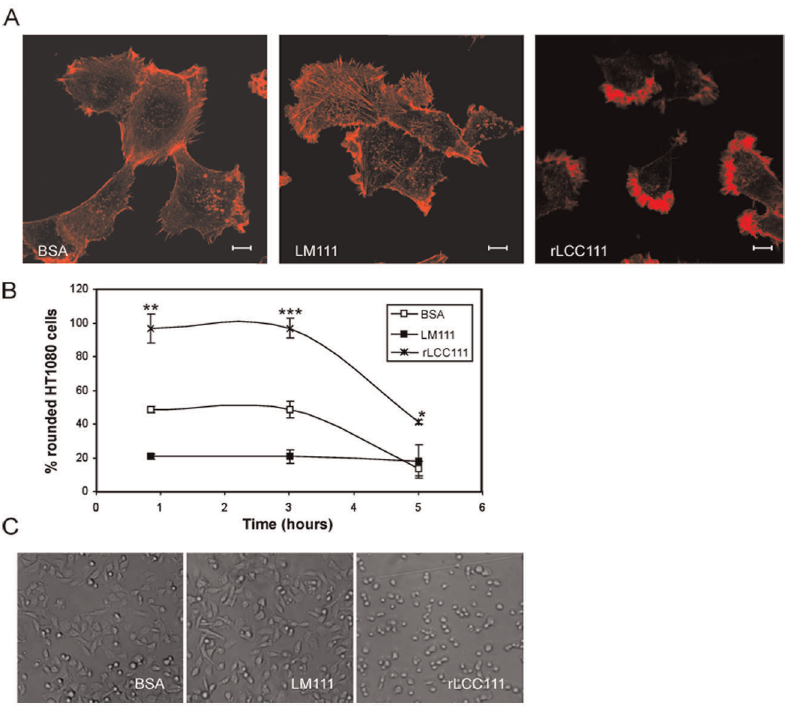
Figure 6. Morphology of HT1080 cells cultured on tissue culture plates coated with BSA, intact LM111 or rLCC111 (10 mg/ml). Cells were allowed to attach for 6 hours, followed by fixation and staining with Alexa Fluor 594 phalloidin (A). Scale bar is 10 m m. Spread and non-spread cells were counted and percentages of non-spread cells are indicated (B). Spread cells were defined as large cells with extensive visible lamellipodia, whereas non-spread cells were defined as round cells with little or no membrane protrusions. Spread and non-spread cells were counted in four high- power fields and represented as mean 6 SD for each condition and time point. The data were evaluated by t test and were considered to be statistically significant when p # 0.05. (*, p , 0.05; **, p , 0.005, ***, p , 0.005). Representative phase-contrast images are shown from one of three